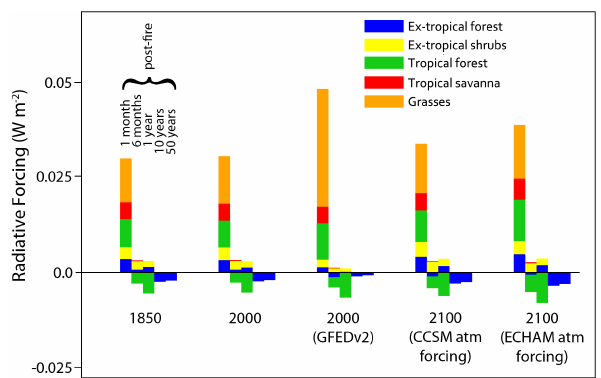
1 Fig. 10. Global RF due to land surface albedo change from fires Fig. 10. Global RF due to land surface albedo change from fires plotted for major biomes and for 2 plotted for major biomes and for different lengths of time after the different lengths of time after the fire occurred. Each set of bars represents different fire emissions from 3 fire occurred. Each set of bars represents different fire emissions CLM3 or from GFEDv2 as indicated by the labels. 4 from CLM3 or from GFEDv2 as indicated by the